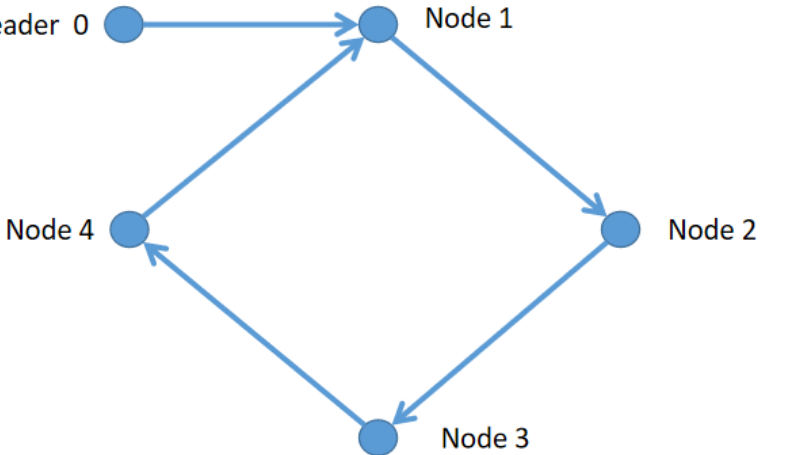
Figure 1. The communication digraph structure.